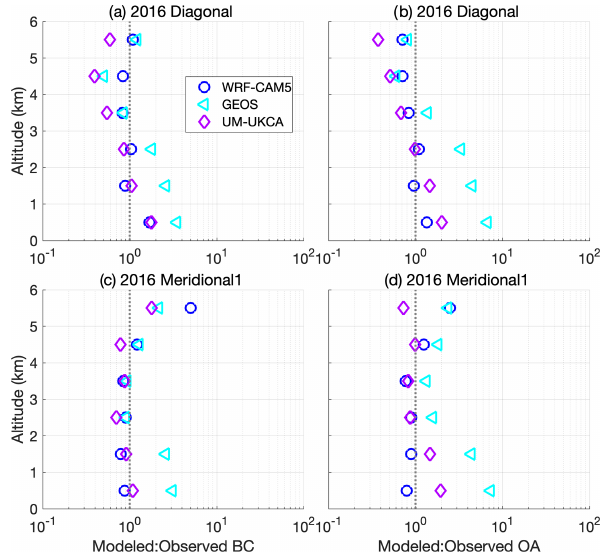
Figure 12. Mean ratio of modeled-to-observed BC mass (a, c) and OA mass (b, d) across all eight grid boxes along the 2016 diago- nal (a, b) and meridional 1 (c, d) comparison transects. The ratios for individual grid boxes, along with these means, can be seen in the Supplement (Fig. S8 for WRF-CAM5, Fig. S10 for GEOS, and Fig. S12 for UM-UKCA).